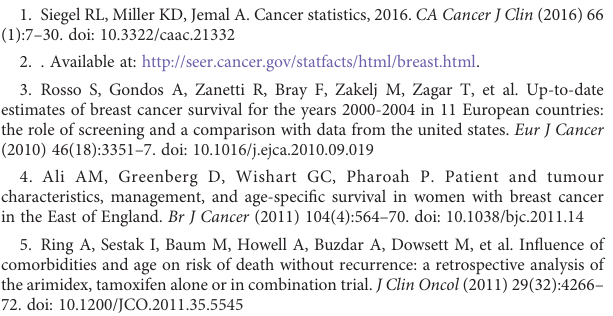
SUPPLEMENTARY FIGURE 1 Management fl ow chart of